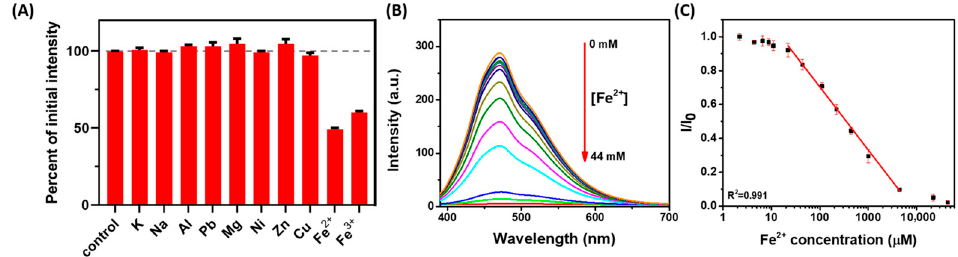
Figure 2. ( A ) The effect of quenching (I/I 0 ) induced by the presence of common metal ions on the PL of His-AuNCs at 471 nm. ( B ) PL spectra of His-AuNCs in the presence of Fe 2+ ions with concentration in the 0–44 mM range. ( C ) PL intensity ratio (I/I 0 ) of His-AuNCs at 471 nm as function of [Fe 2+ ] along with the linear fitting function used, revealing a linear dynamic range from 0.022 to 4.4 mM. λ ex = 380